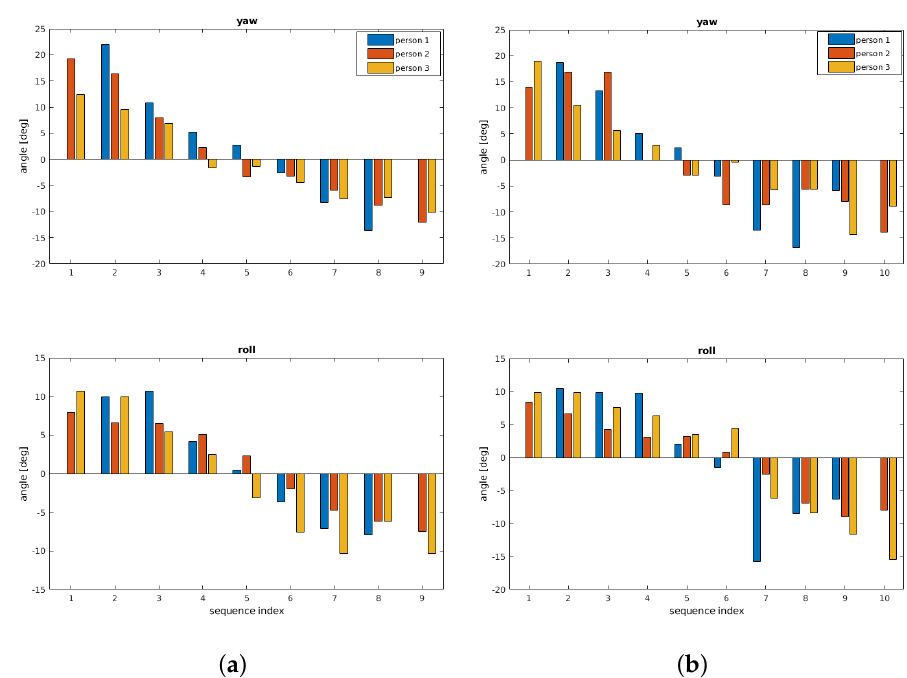
Figure 14. The bone B2 shows similar to B1 a yaw rotation plus a concurrent tilt as roll rotation. ( a ) shows results using the average bone as reference and ( b ) shows results using the corresponding center bone of the hand movement as reference. ( a ) Original yaw/roll rotation B2, comparison of all three probands. ( b ) Registration within tissue (reference from center hand